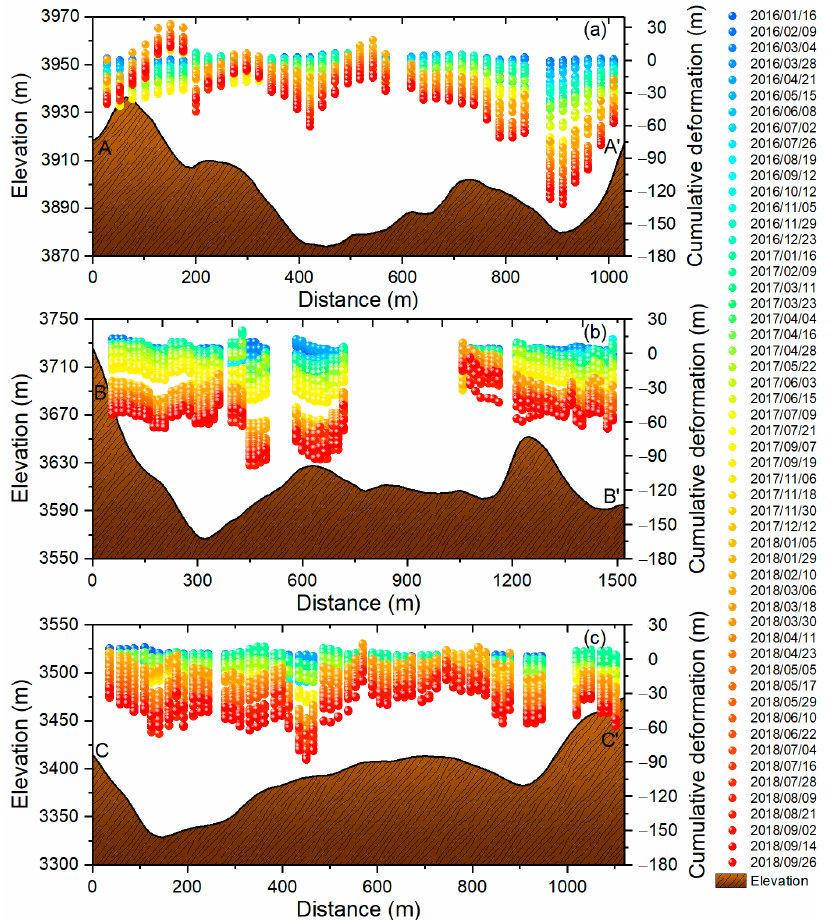
Figure 6. The cumulative time series of the deformation along profiles ( a ) AA’, ( b ) BB’ and ( c )